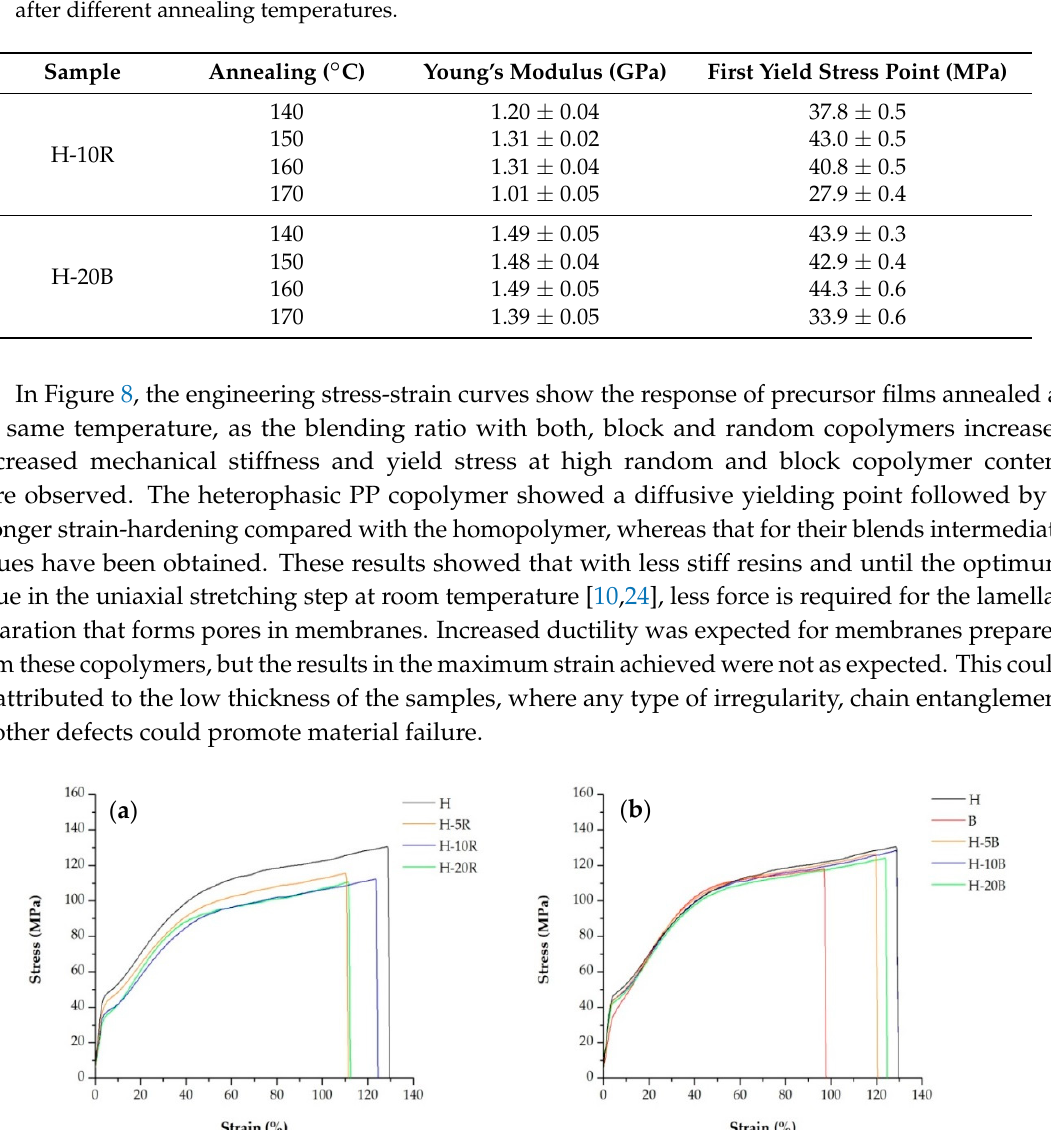
Table 7. Results of the tensile test along MD for precursor films of PP random and block copolymers after different annealing temperatures.